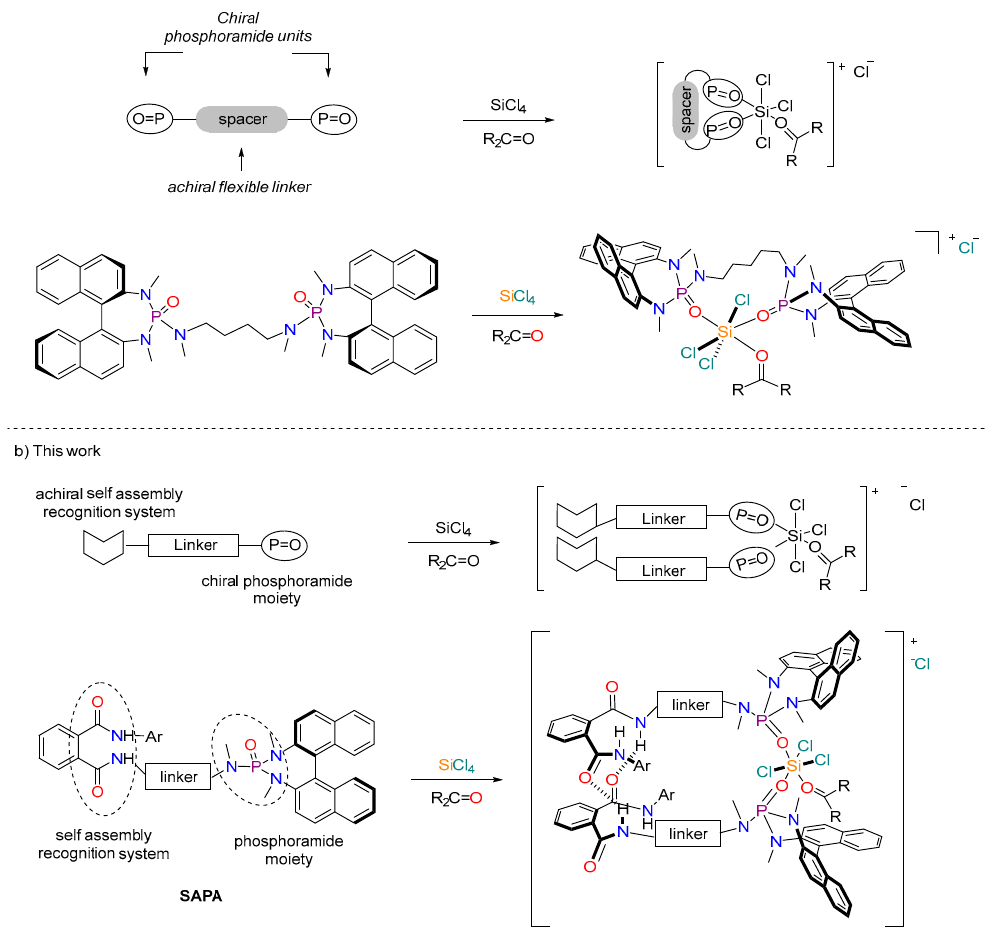
Figure 2. ( a ) Traditional approach for the activation of SiCl 4 using bis-phosphoramides; ( b ) Design and the synthesis of SAPAs Lewis bases. the synthesis of SAPAs Lewis